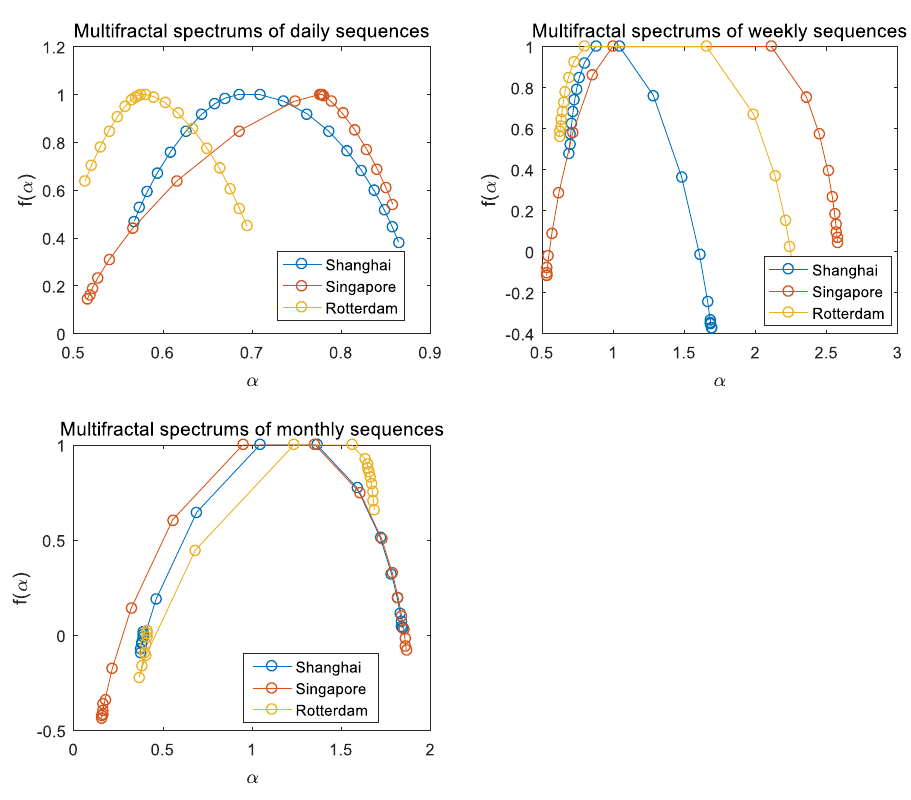
Figure 7. Multifractal spectra for ship flow sequences of three ports with different time scales. Compared with the daily ship flow time series, the multifractal spectra of Shanghai and Rotterdam obtained from weekly ship flow sequences shifted to the left and the spectrum is slightly left-skewed. This indicates that the scaling behavior of large fluctuations dominates the fluctuation of the weekly ship flow for Shanghai and Rotterdam